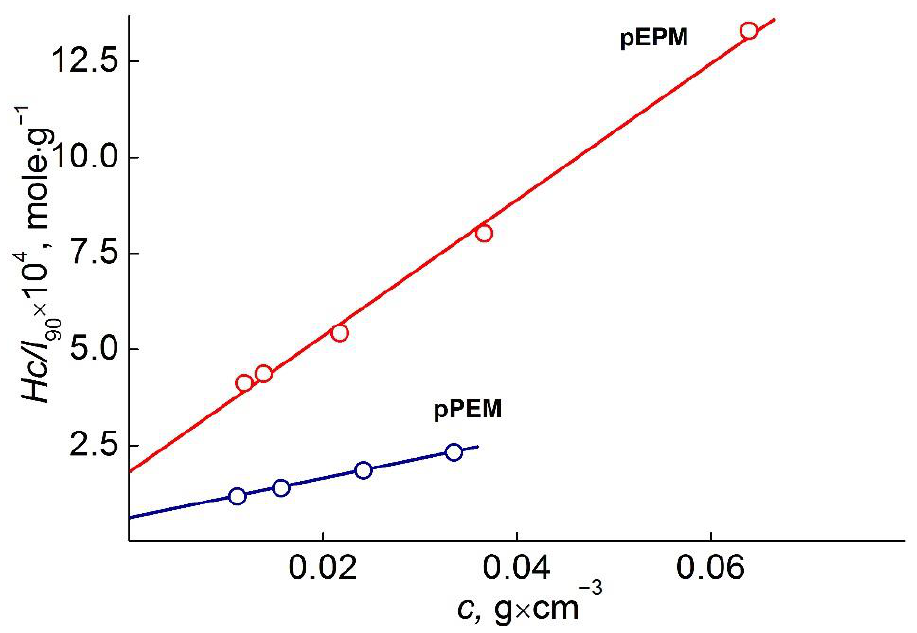
Figure 4. Debye plots for pPEM and pEPM in acetonitrile.